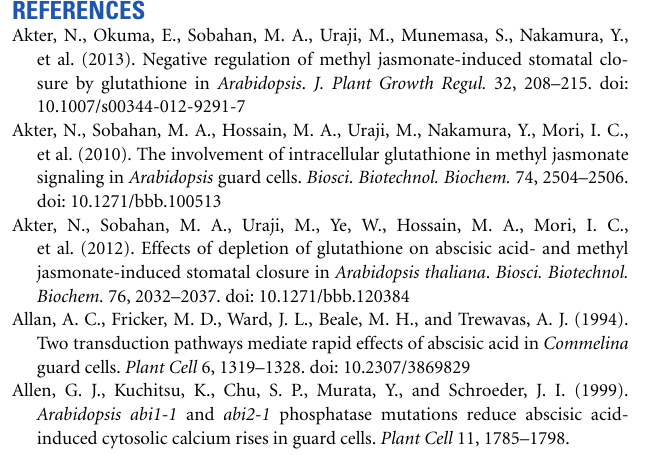
Figure S1 | GSHmee attenuates enhanced stomatal response to H 2 O 2 of the cad2-1 mutant. Detached rosette leaves of the cad2-1 mutant were incubated on stomatal assay buffer (see Materials and Methods) with or without 10 μ M GSHmee for 2h in the light, followed by the addition of 100 μ M H 2 O 2 . Stomatal apertures were measured 2h after H 2 O 2 application. Twenty averages from three independent experiments (60 total stomata per bar) are shown. The bars represent the mean ± SE